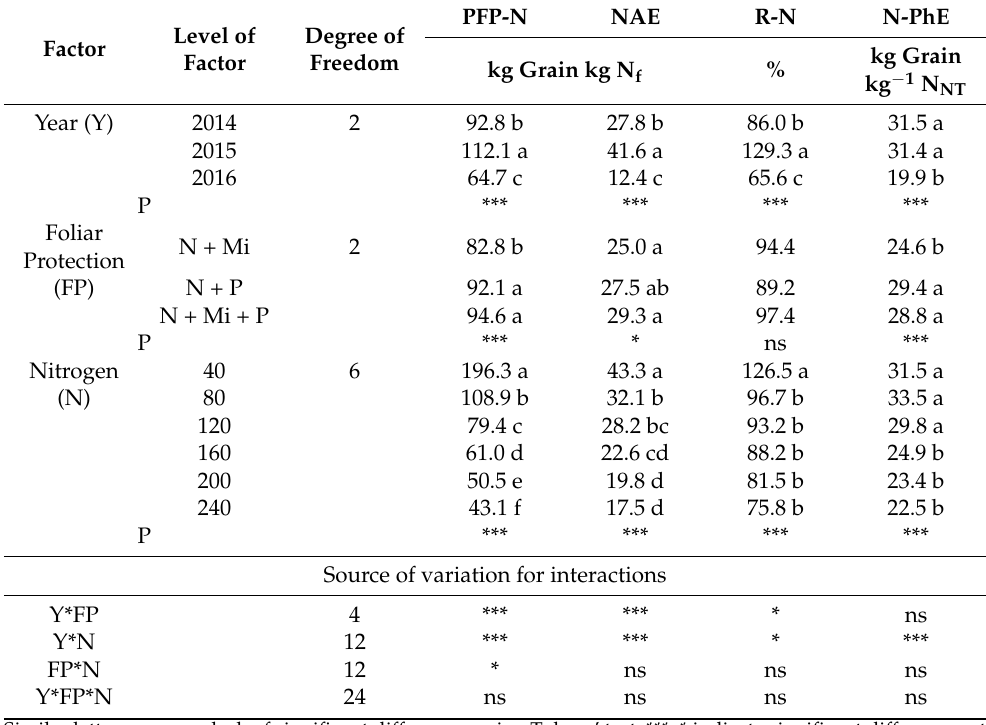
Table 6. Statistical evaluation of factors affecting nitrogen efficiency indices.